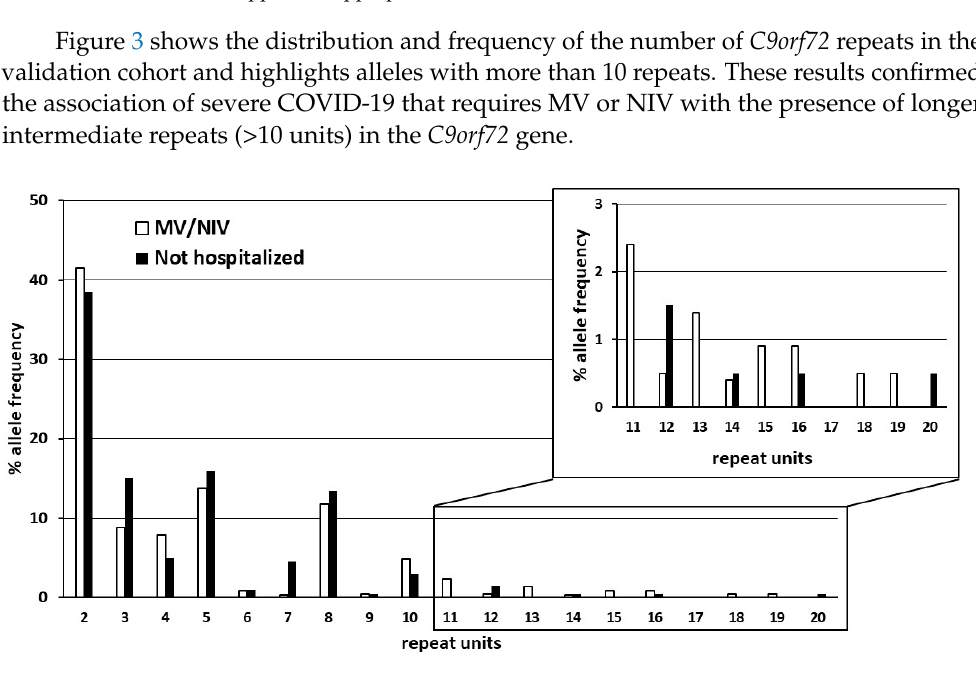
Figure 3. Histogram showing the distribution and frequency (%) (Y-axis) of the number of C9orf72 hexanucleotide repeats (X-axis) in patients’ alleles in severe COVID-19 patients who received mechanical ventilation (MV) or non-invasive ventilation (NIV) (white bars) and non-hospitalized SARS-CoV-2 infected subjects (asymptomatic or with very mild symptoms) (black bars).